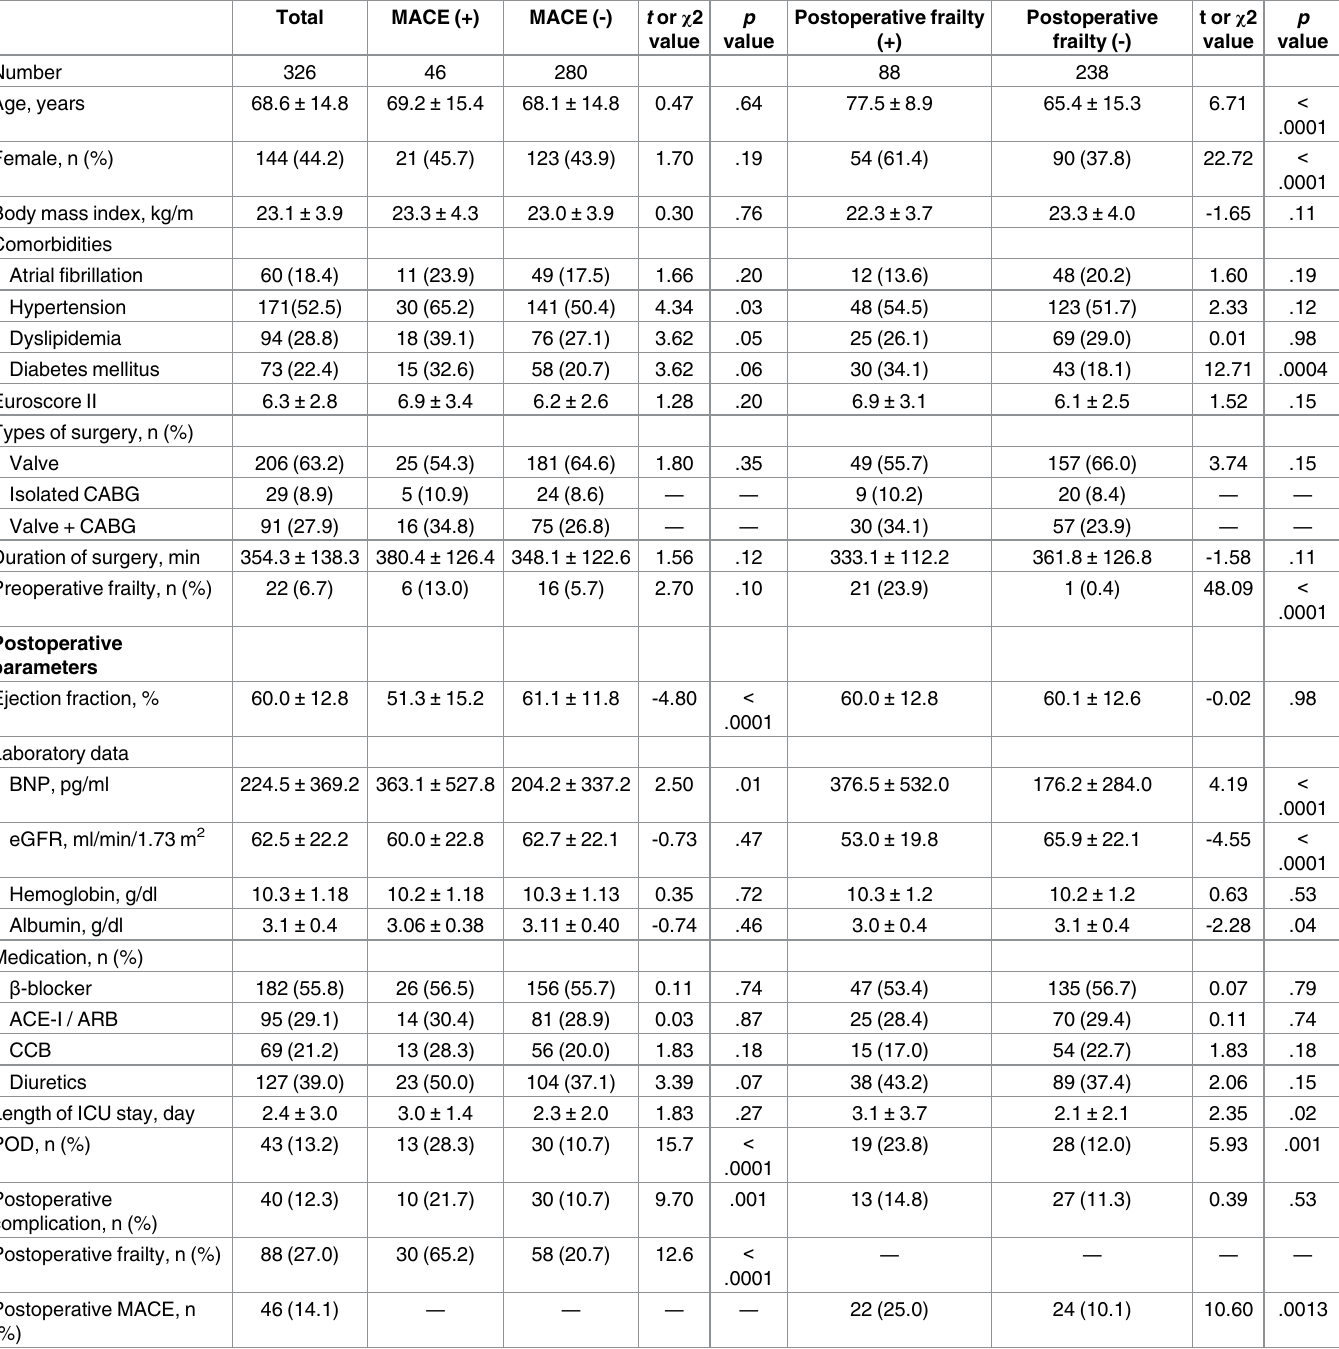
Table 1. Comparison of baseline characteristics in patients with or without MACE, and with or without postoperative